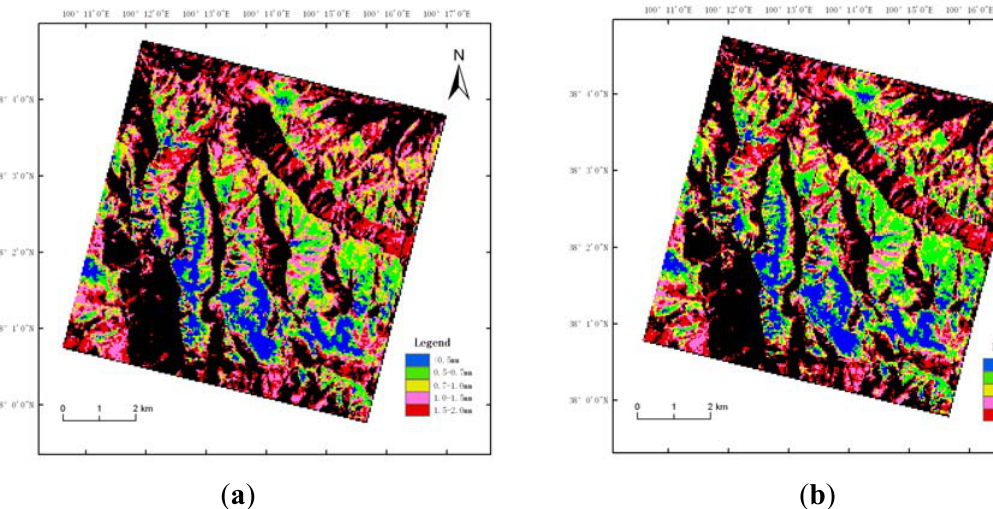
Figure 12. Distribution of the snow grain size estimated using the linear and exponential models. ( a ) Linear model, ( b ) Exponential